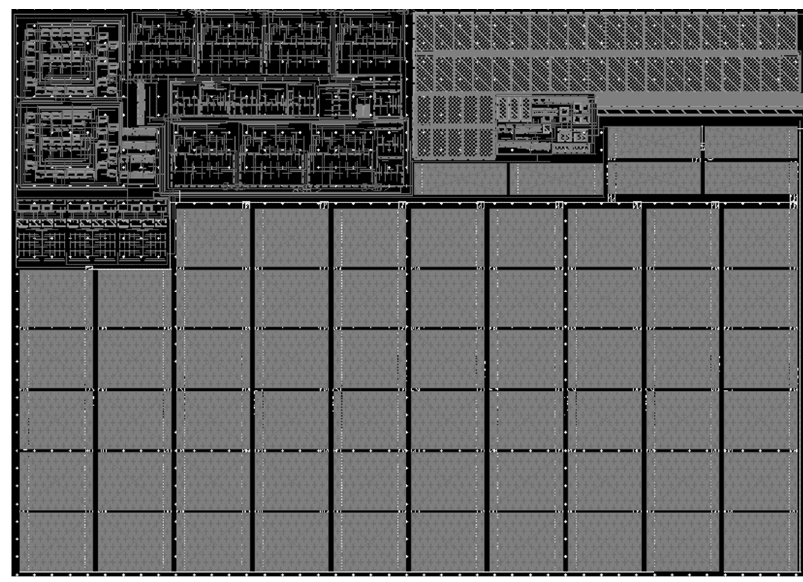
Figure 14. Layout of the hardened PLL. Table 1. Performance comparison of the PLL before and after